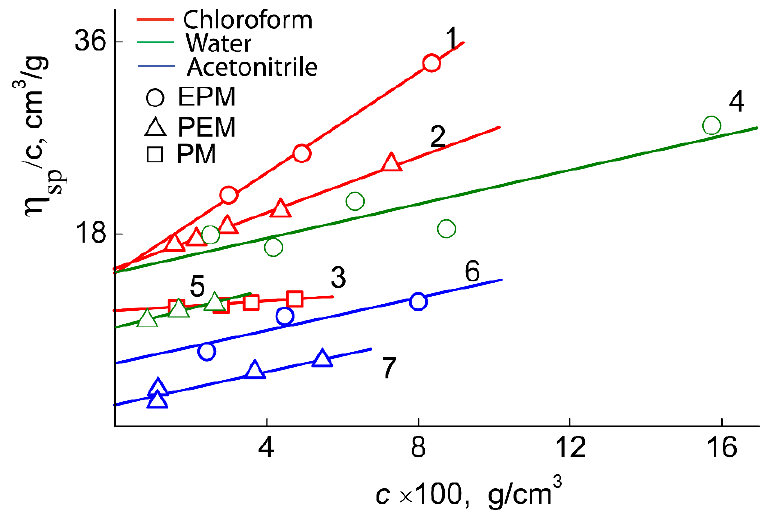
Figure 7. The dependencies η sp /c vs. concentration for pEPM in chloroform (1), pPEM in chloroform (2), pPM in chloroform (3), pEPM in water (4), pPEM in water (5), pEPM in acetonitrile (6), pPEM in acetonitrile (7).